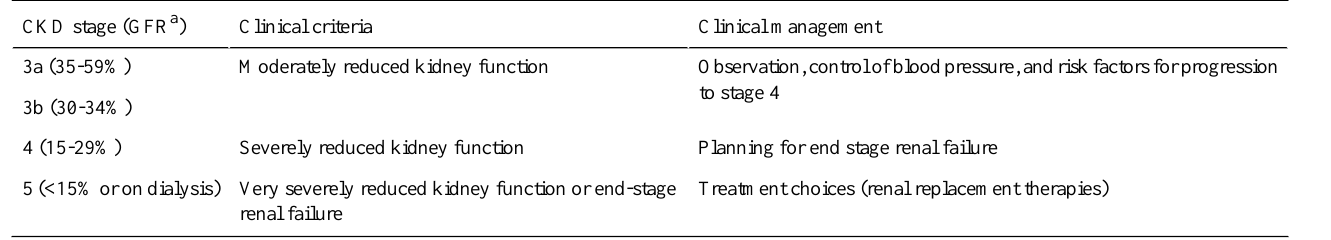
Table 1. Chronic kidney disease stages 3-5 (adapted from the Renal